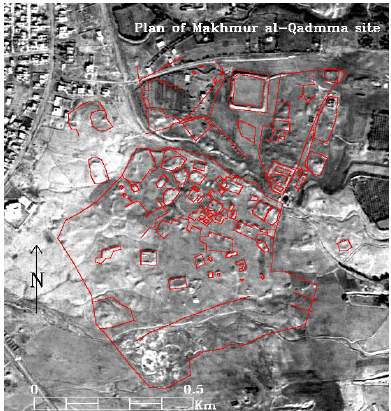
Figure 8 - Plan of Makhmúr al-Qadíma archaeological site based on FORMOSAT-2 band